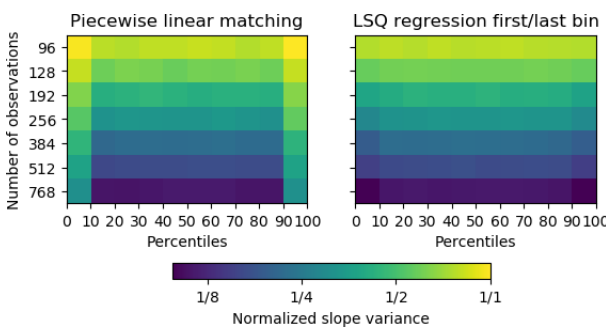
Figure 2. Variance of the derived slope, depending on the num- ber of observations and the percentile bin for both piecewise linear CDF-matching techniques. The colour is